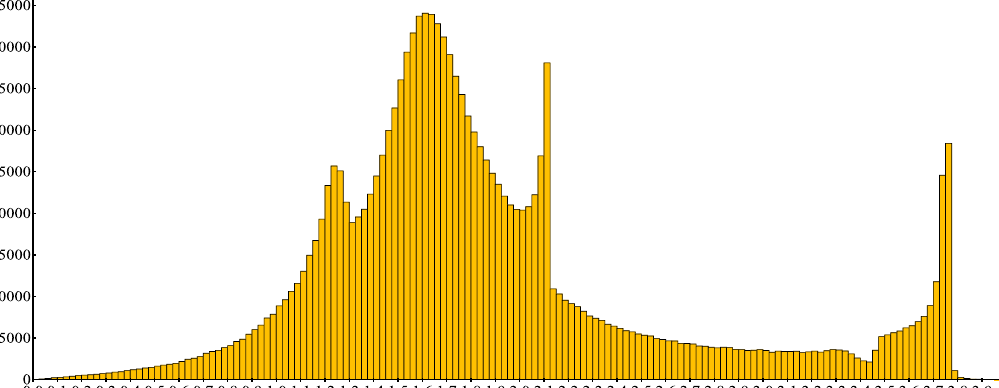
Figure 1 . The distributions of All vacua here satisfy the BF bound.